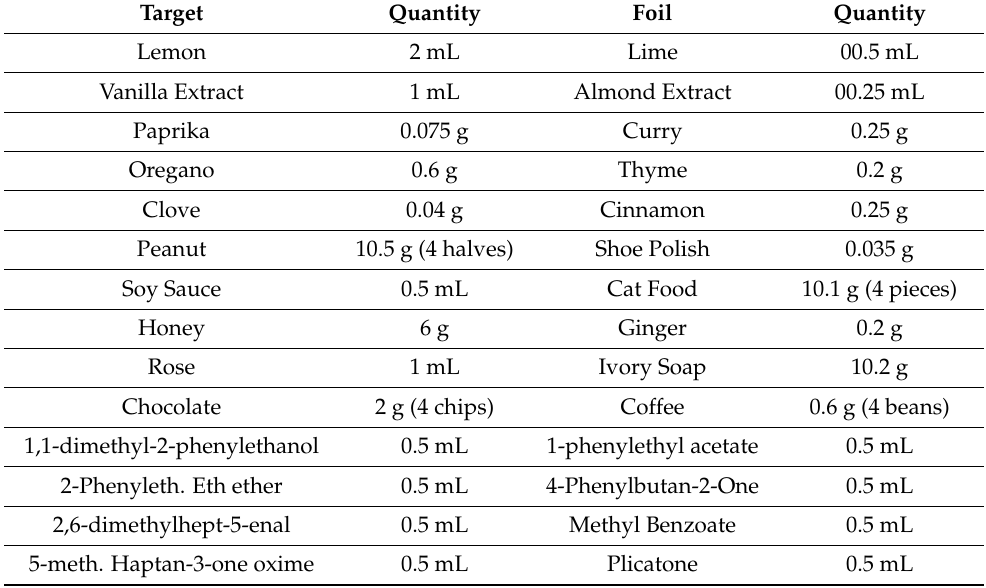
Table A1. Common and uncommon odors, in